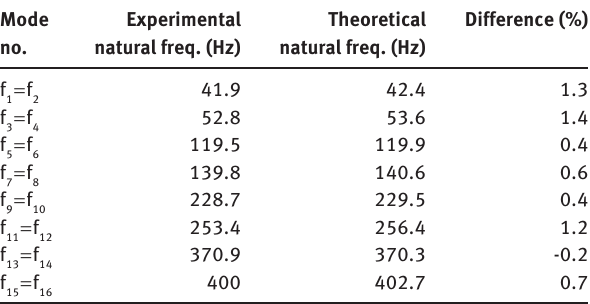
Table 9: Comparison between natural frequencies of truncated cone # 2 (experiment and theory).